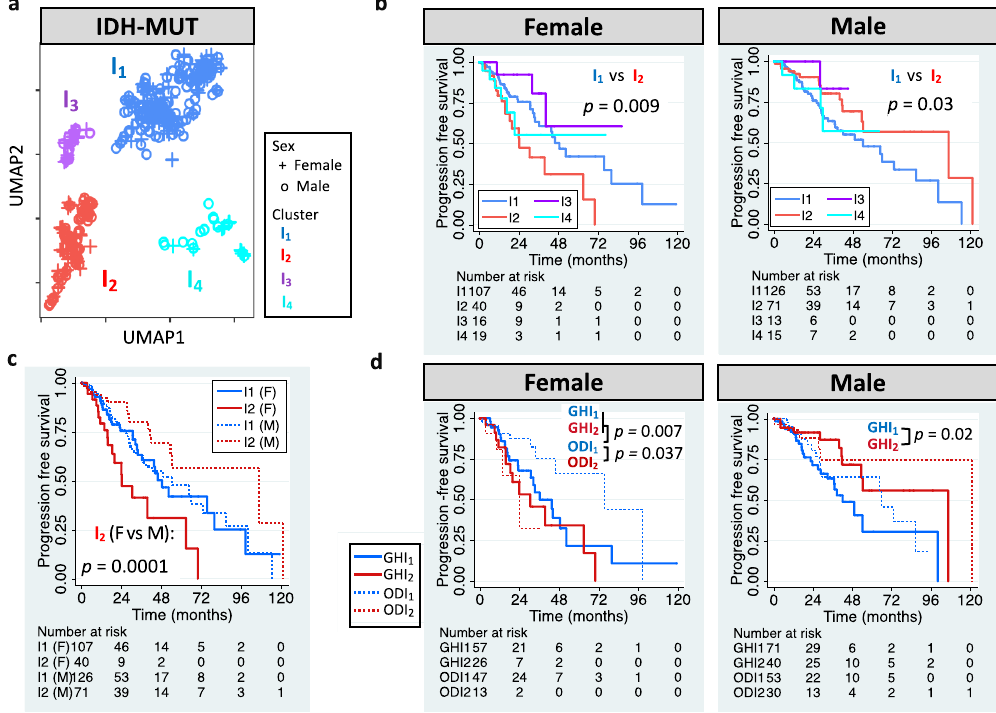
Figure 2. RNA editing-based subtyping of IDH-MUT samples . ( a ) UMAP of IDH-MUT gliomas (I 1 –I 4 ). ( b ) Kaplan–Meier (KM) curves for UMAP clusters (I 1 –I 4 , log-rank test). ( c ) KM curves for I 1 and I 2 . ( d ) KM curves for I 1 and I 2 of astrocytoma with high levels of DNA methylation (GH) and oli- godendroglioma (OD).